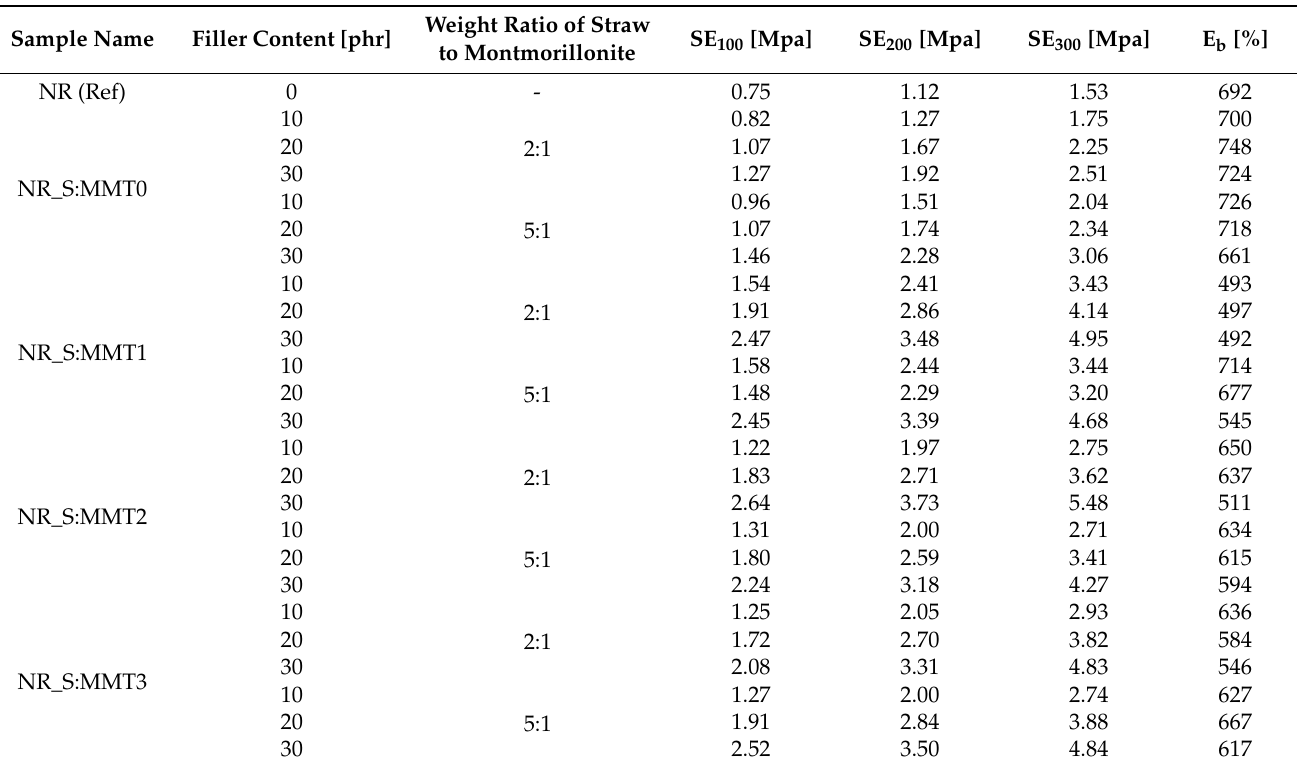
Table 6. Mechanical properties of vulcanizates under static tensile conditions; standard deviations: SE 100, 200, 300 ± 0.2 MPa, E b ±